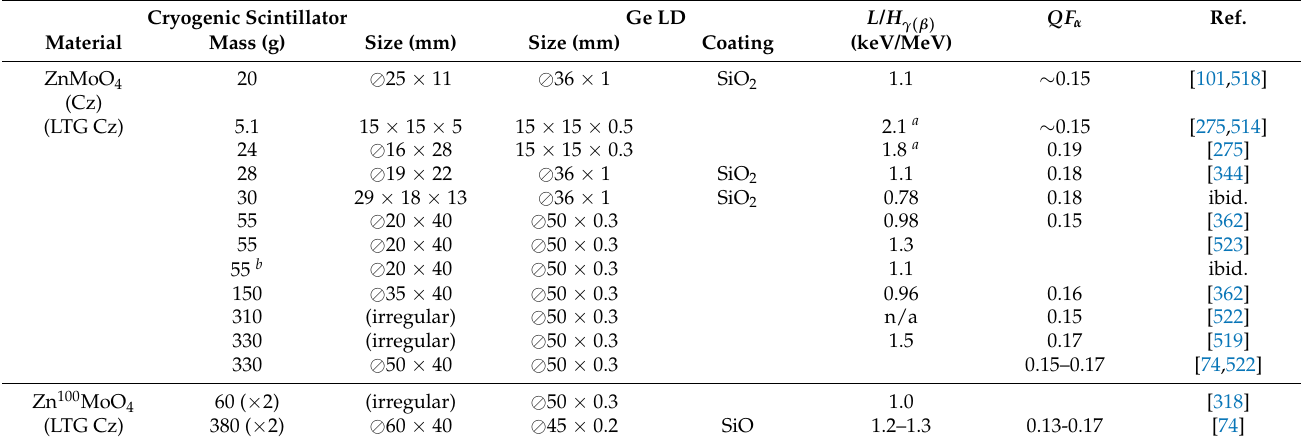
Table 6. Results of low-temperature scintillation detection with scintillating bolometers based on natural/ 100 Mo-enriched ZnMoO 4 crystals and thin Ge LDs. The crystal growth method, the mass (two significant digits) and the size of the sample, the size and the coating of the coupled LD, as well as the L / H γ ( β ) and QF α values are listed. Cryogenic Scintillator Ge LD L / H γ ( β ) QF α